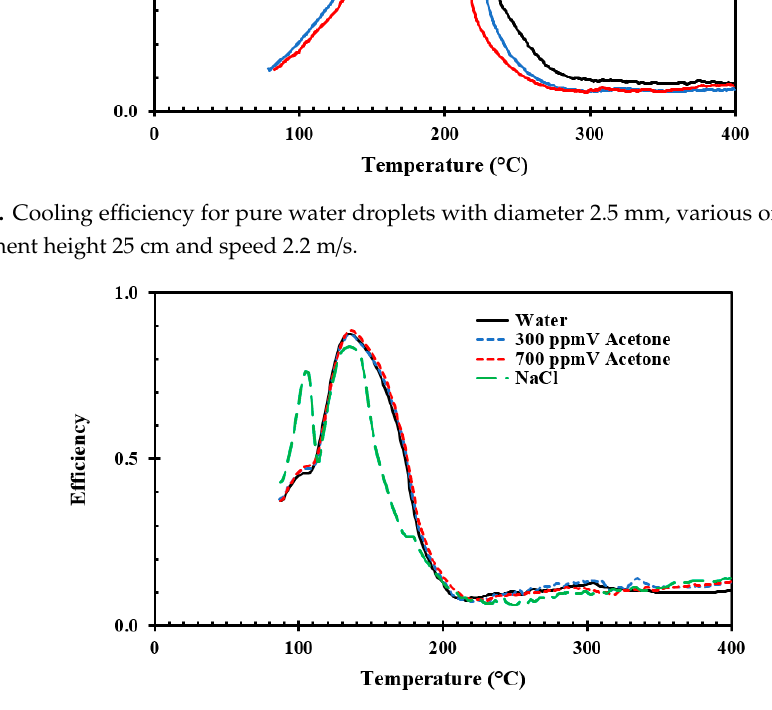
Figure 12. Cooling efficiency for pure water droplets with diameter 2.5 mm, various orientations at impingement height 25 cm and speed 2.2 m/s.